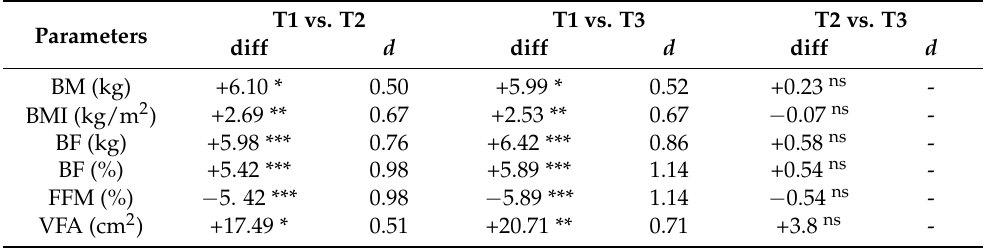
Table 4. Results of the post hoc tests of the whole-body analysis of the monitored women. T1 vs. T2 Parameters